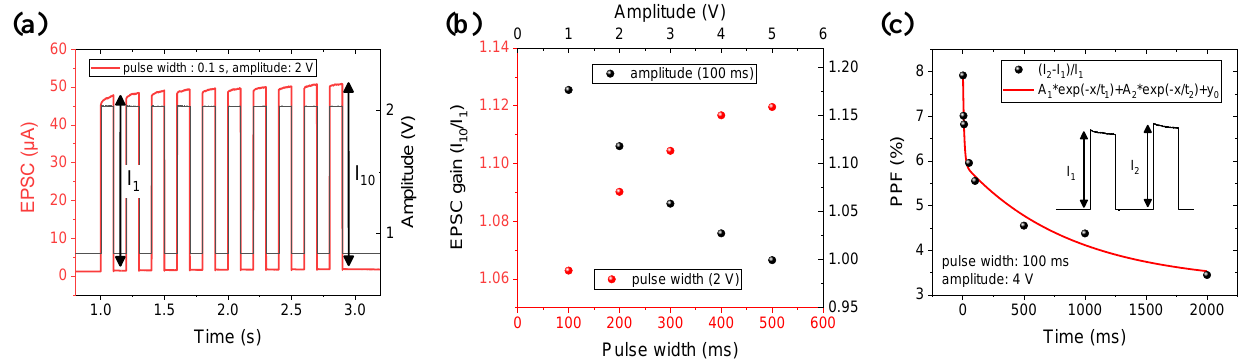
Figure 6. ( a ) EPSC fired by repeated pulses with short interval time that is before returning to the initial state. I 1 and I 10 are the currents triggered by the first pulse and the tenth pulse, respectively. ( b ) EPSC gain (I 1 /I 10 ) plotted according to pulse width and pulse amplitude. Fixed 2 V at different pulse widths (from 100 ms to 500 ms), on the other sides, fixed 100 ms at different pulse amplitude (from 1 V to 5 V). ( c ) PPF (%), as a definition of (I 2 − I 1 )/I 1 , illustrated current increasing due to the interval time of a paired-pulse.